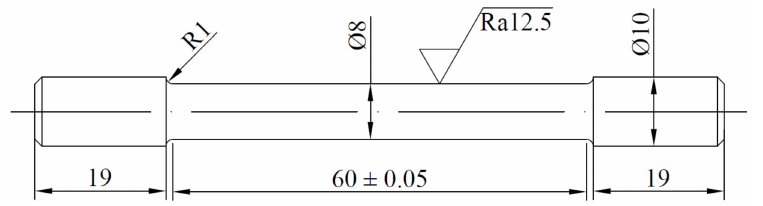
Figure 3. Geometric dimensions of the tensile specimen.